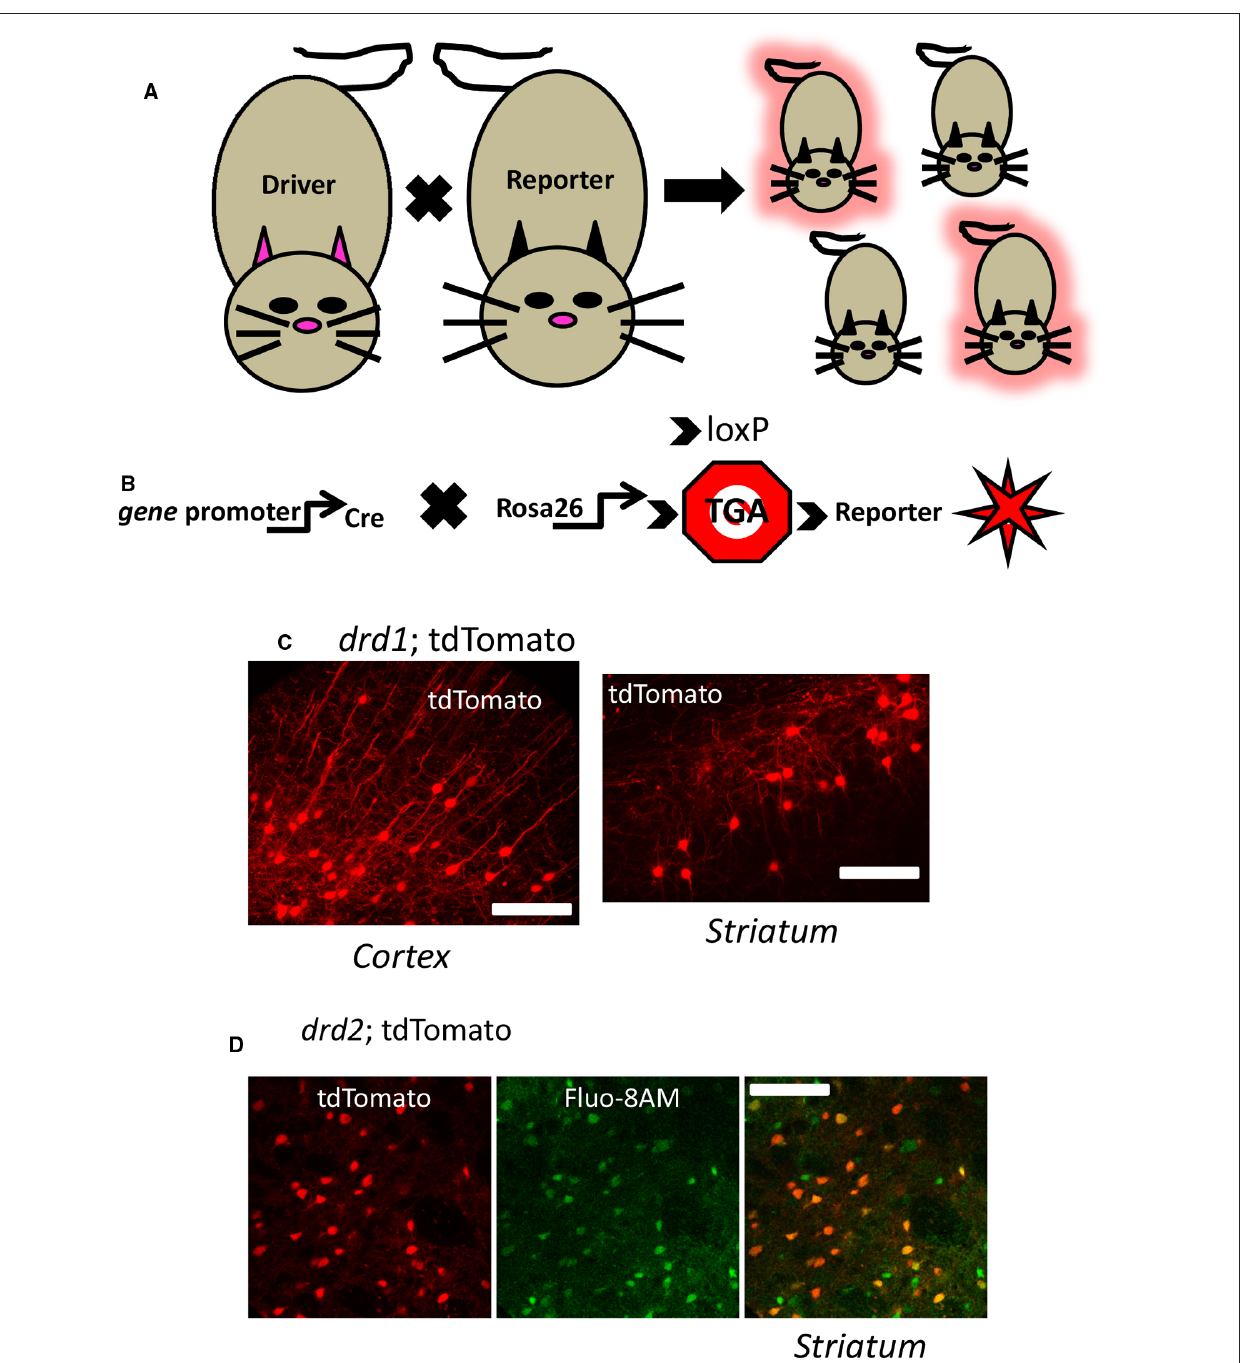
genetically encoded fluorescent reporters ( red star symbol) in the target cell population. (C) Illustrates a confocal image of a coronal mouse brain section from an animal inheriting the drd1 ; cre and rosa26 ; tdTomato genes described above, permitting fluorescent detection of dopamine D1 cells in cortex ( left ) and striatum ( right ). (D) Live confocal image of an acute striatal brain slice showing drd2 : tdTomato neurons (red, left ) and the same section bulk loaded with the calcium sensitive dye Flou-8 (green, center ), allowing genetic identification of striatal neurons while imaging calcium (superimposed images, right ). See Partridge et al. (2014) for methods. Scale bars in (C) and (D) : 100 µ